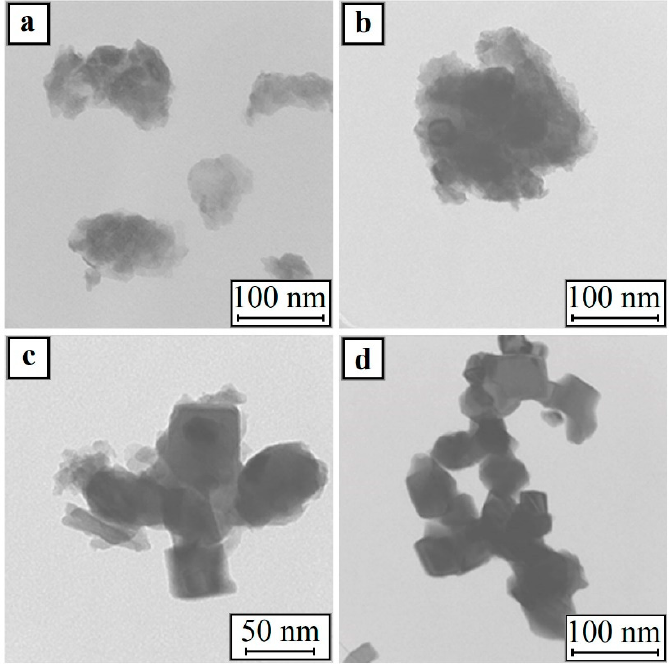
Figure 10. TEM images of the samples: ( a ) Ni 20;9;d;200;45 ; ( b ) Ni 20;9;c;200;90 ; ( c ) Ni 20;9;d;220;30 ; and ( d ) Ni 20;9;d;280;15.